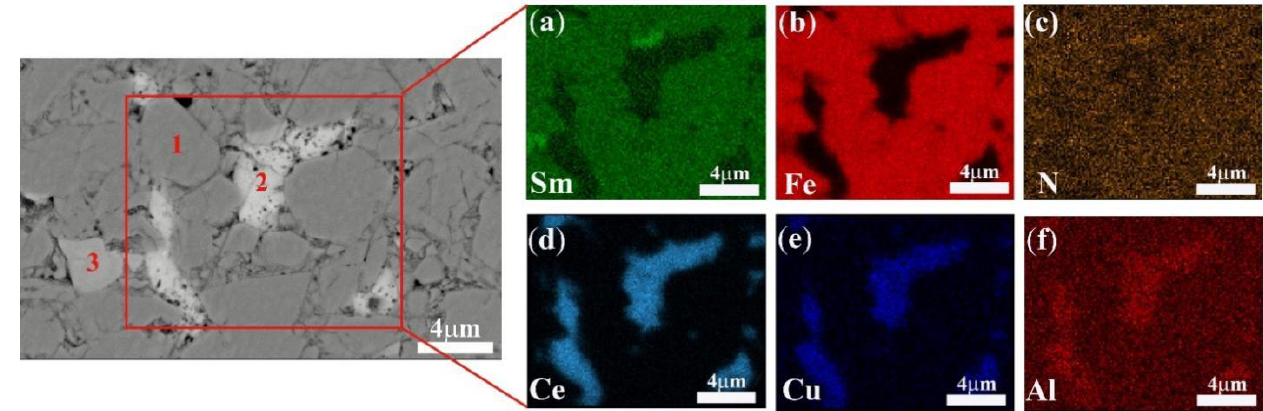
Figure 8. EDS spectra of a polished cross-section from Sm-Fe-N bonded magnet using Ce 72 Cu 22 Al 6 powder binder and elemental distribution maps of ( a ) Sm, ( b ) Fe, ( c ) N, ( d ) Ce, ( e ) Cu, and ( f ) Al.